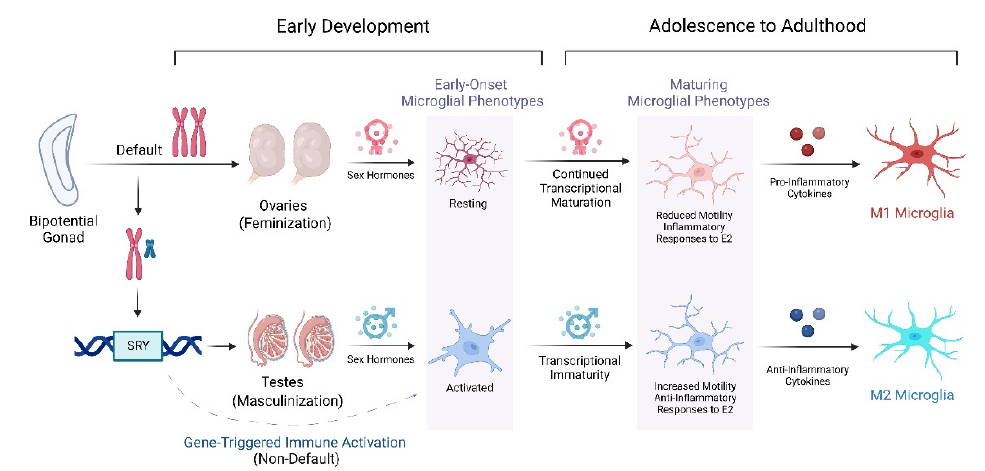
Figure 1. Sexually dimorphic microglial development. Default developmental programming that results in producing ovaries is altered by the presence of the SRY gene on the Y chromosome, producing testes. Sex hormones generated from these gonads (estrogen from ovaries, testosterone from testes) shape initial microglial phenotypes, with increased activation seen in males. Developmental maturation shortly downregulates in male microglia, ultimately assuming a more transcriptionally immature profile compared to female microglia that continue to mature. Cytokine production and differential responses to estradiol (E2) dictate an overall M1 predominance in females and M2 predominance in males. (Created with BioRender.com on 6 February 2023). Table 1. Microglial cells are predominantly M1 in females, and predominantly M2 in